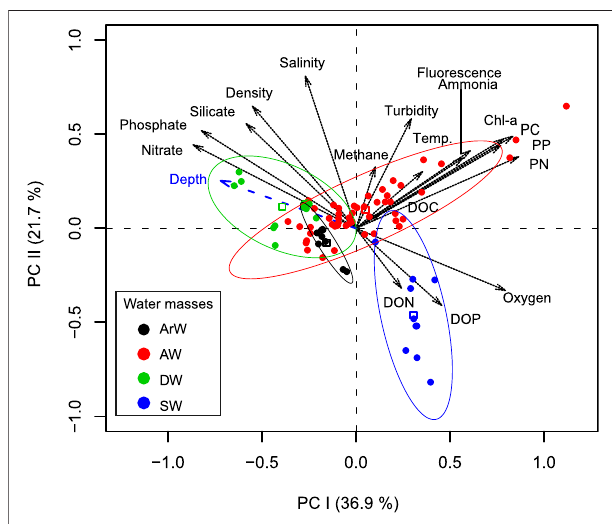
FIGURE 5 | Principle Component Analysis biplot of the biochemical parameters. The explained variances are provided on the x- and y-axis in parentheses. Coloured ellipses represent 95% con fi dence interval for water mass group centroids of Surface water (SW), Deep Water (DW), Atlantic Water (AW), and Arctic Water (ArW). Centroids are represented by open square symbols. Abbreviations are PC, PN, PP, particulate carbon, nitrogen and phosphorus; DIN, dissolved inorganic nitrogen; DOC, DON, DOP, dissolved organic carbon, nitrogen and phosphorus; Chl-a, Chlorophyll a.